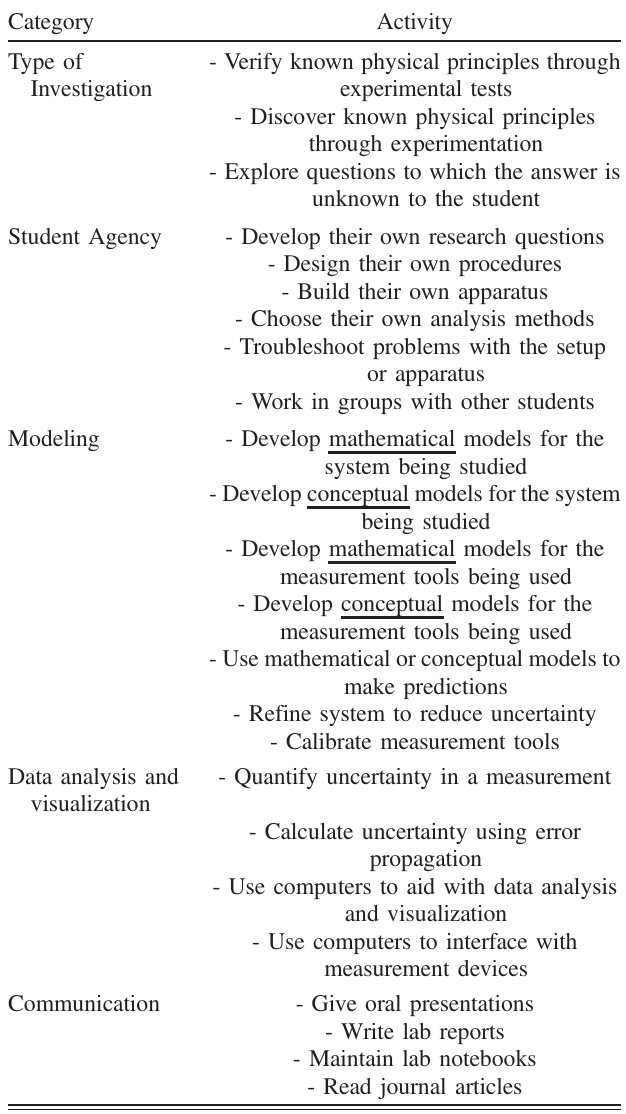
TABLE I. List of lab activities presented on the CIS. Instructors were asked to indicate the frequency (never, rarely, sometimes, often, or always) with with their students engaged in these